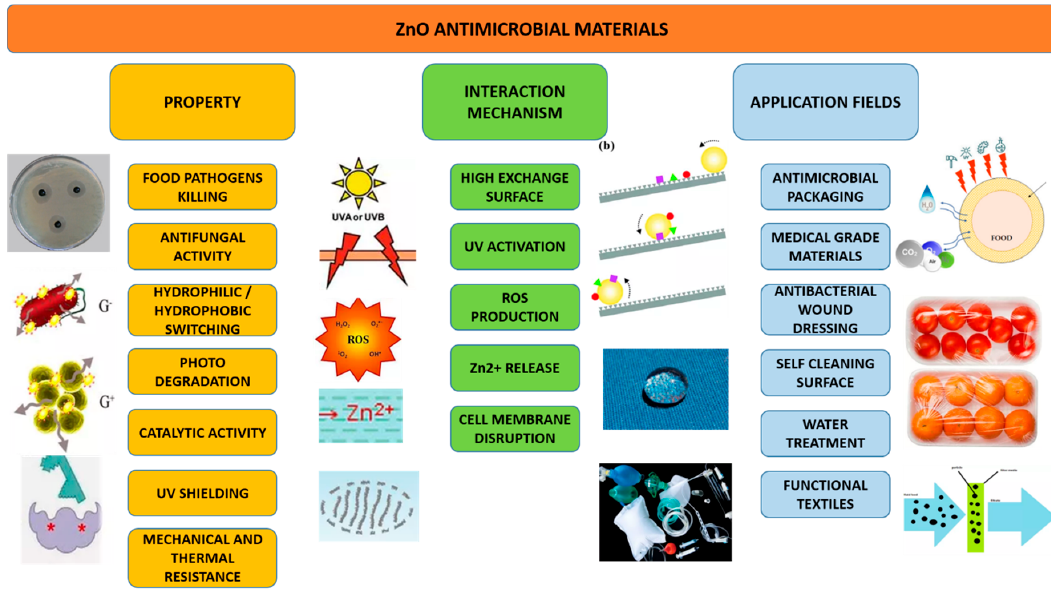
Figure 8. Properties, mechanisms of action, and applications of new ZnO-based antimicrobial materials.